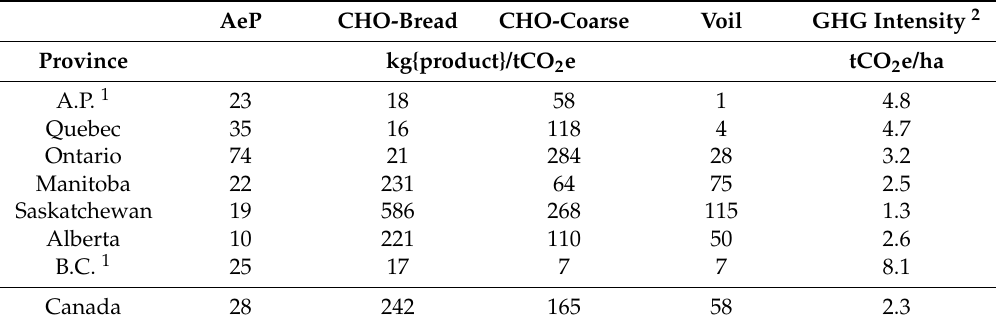
Table 7. The weight of farm products per t of GHG emissions from all farm operations in 2006, and the total GHG emission intensities for all arable land in each province for 2006: AeP = Animal-equivalent Protein; CHO = carbohydrates; bread = food quality; coarse = feed grain or industrial use; Voil = vegetable oil. AeP CHO-Bread CHO-Coarse Voil GHG Intensity 2 Province kg{product}/tCO 2 e tCO 2